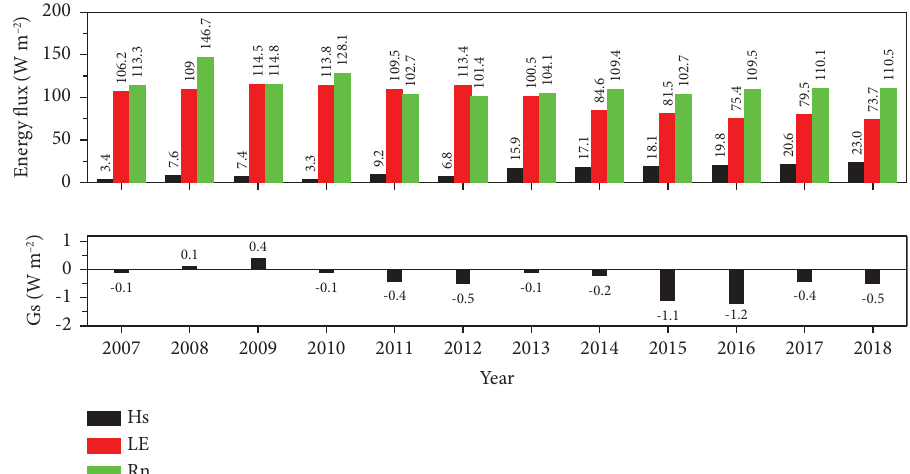
Figure 9: Annual averaged sensible heat fux (Hs), latent heat fux (LE), net radiation fux (Rn), and soil heat fux (Gs) from 2007 to